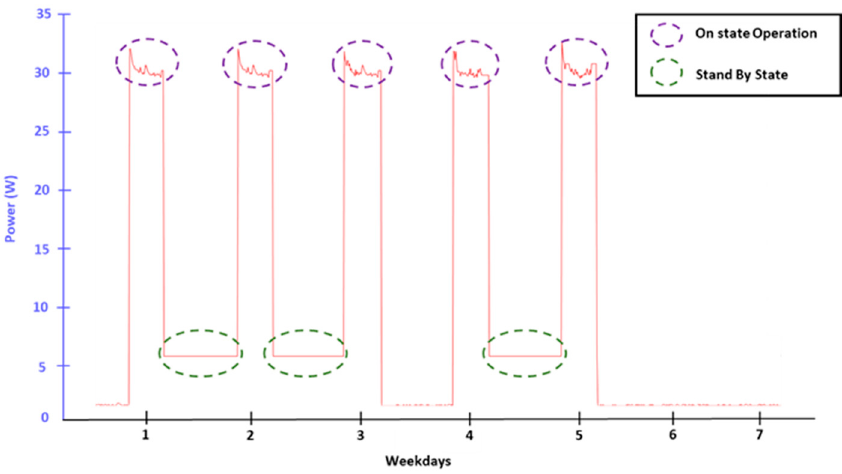
Figure 15. Business processes and Personal Computer (PC)/monitor consumption flexibility analysis.